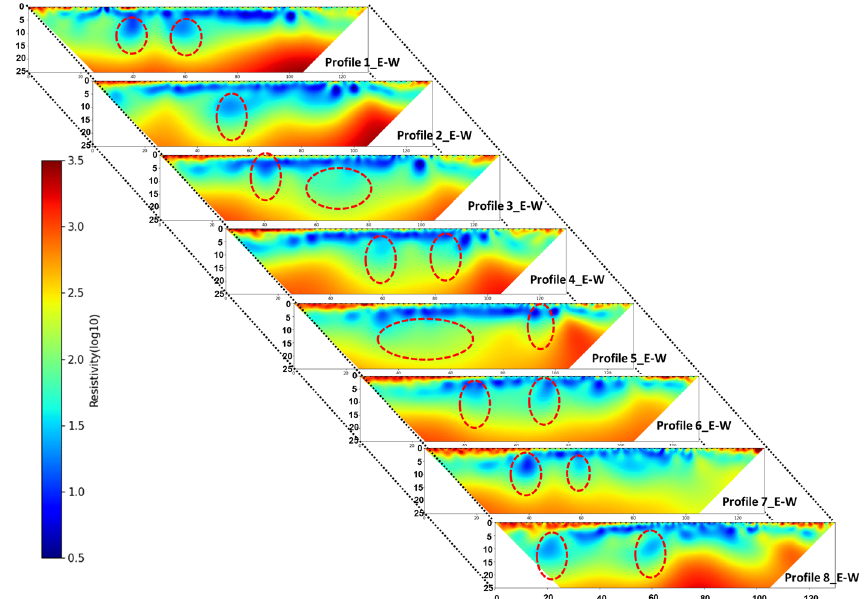
Figure 9. Resistivity models along transacts 1 to 8 acquired in the east–west direction with profiles 6,